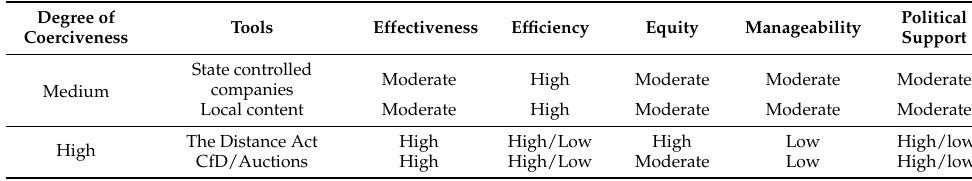
Table 4. Degree of coerciveness.